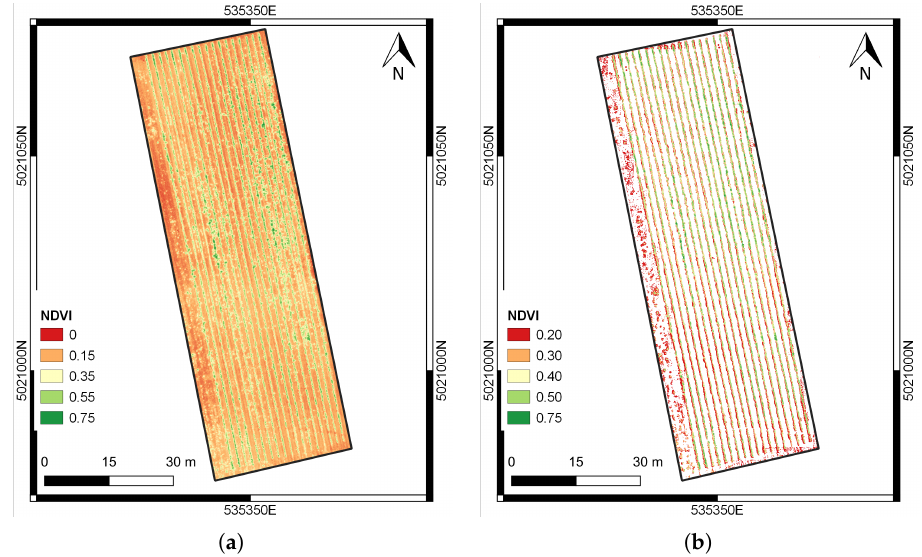
Figure 13. Tomato field site: NDVI map before ( a ) and after ( b ) the crop rows’